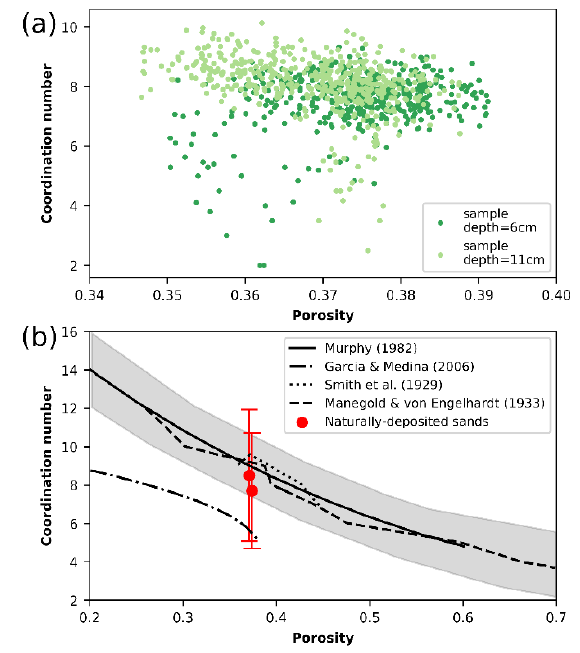
Figure 2. (a) Relationships between coordination number and porosity for recovered sands. We computed porosity and average coordination number on all 500 image slices within each core. (b) Comparison between coordination number for pluviated [1, 3] and modeled [2, 4] sands in the literature and our naturally-deposited sands. The gray shading is the standard deviation for the dataset produced by [2]. We modified the image from [5].